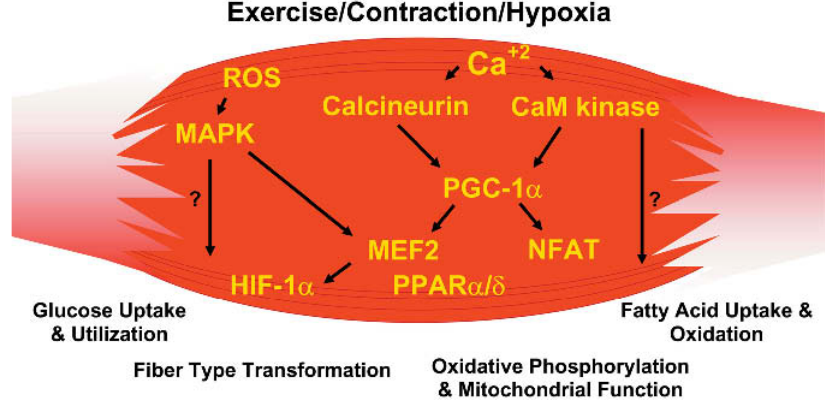
Figure 3. Exercise-Included Signaling Pathways in Skeletal Muscle That Determine Specialized Characteristics of ST and FT Muscle Fibers Contraction-induced changes in intracellular calcium or reactive oxygen species provide signals to diverse pathways that include the MAPKs, calcineurin and calcium/ calmodulin-dependent protein kinase IV to activate transcription factors that regulate gene expression and enzyme activity in skeletal